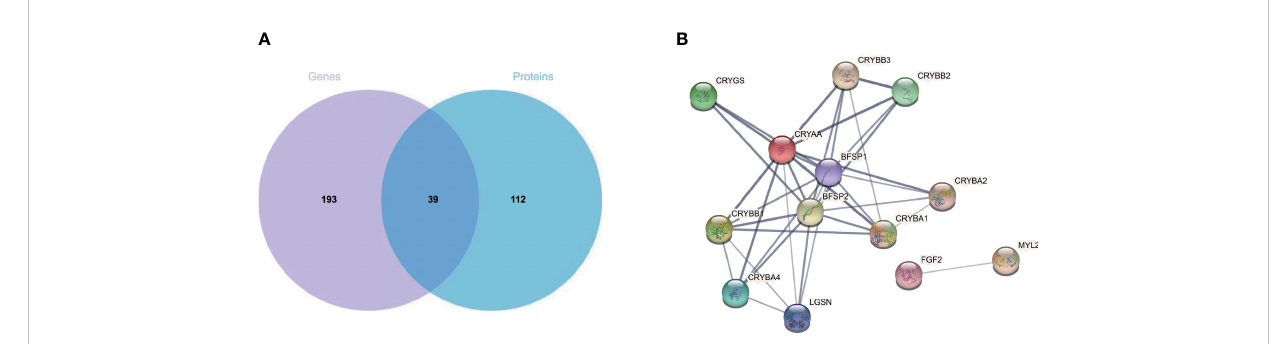
FIGURE 3 Combined transcriptome and proteome analysis. (A) Venn diagram of mRNA and proteins from CNV and control retinas. (B) Protein – protein interaction analysis of differentially expressed proteins. CNV, choroidal neovascularization; mRNA, messenger